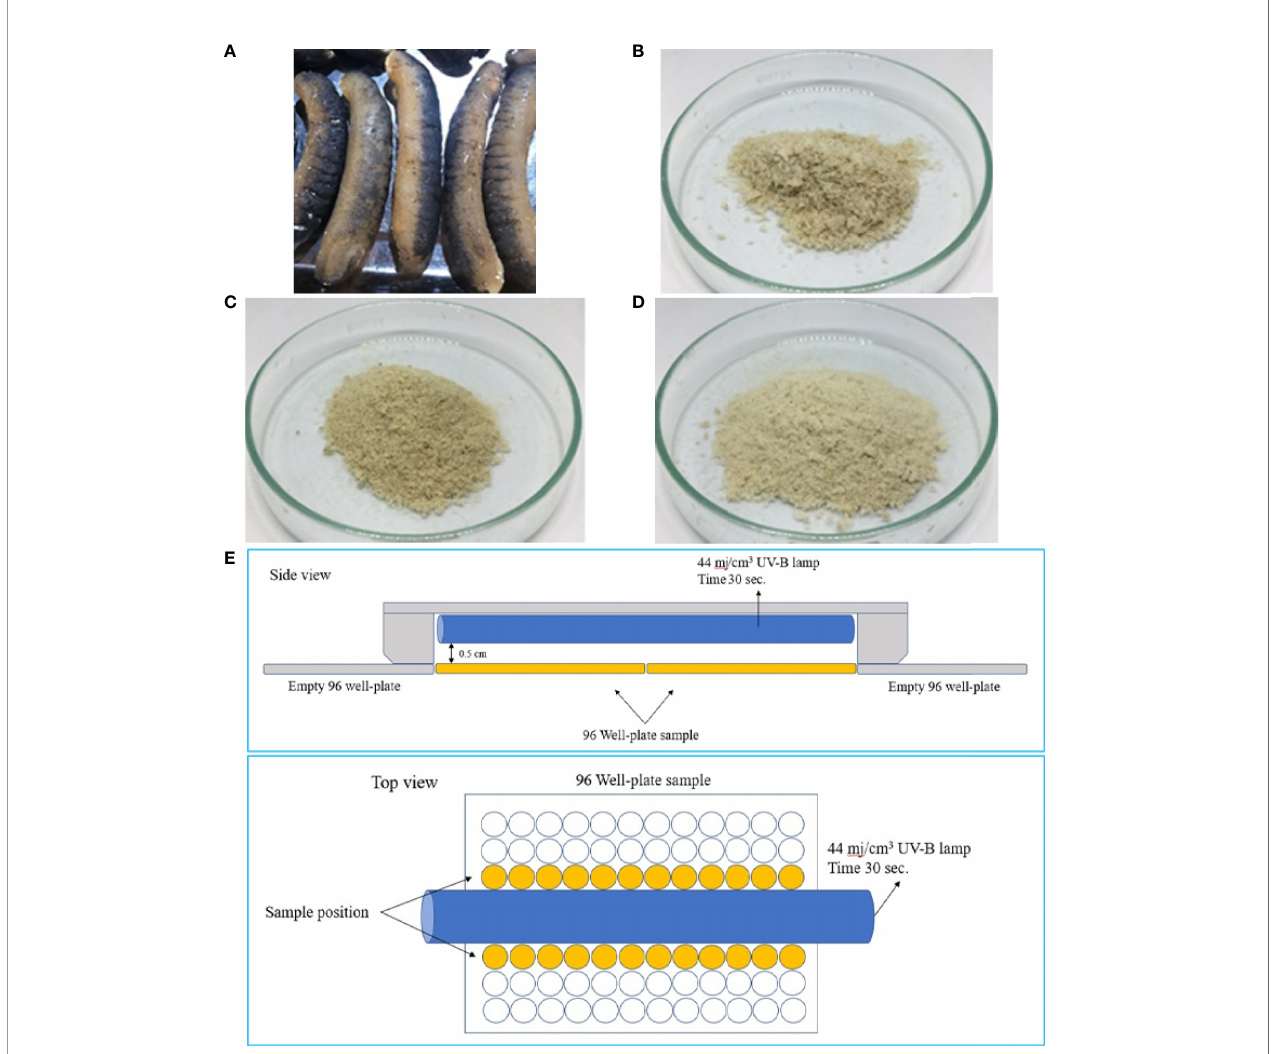
FIGURE 1 | Dried sea cucumber (A) and lyophilized protein hydrolysates obtained using papain (B) , alcalase (C) , and fl avourzyme (D) . Diagram illustrates the experimental setup for UV radiation using a UV-B lamp (E)